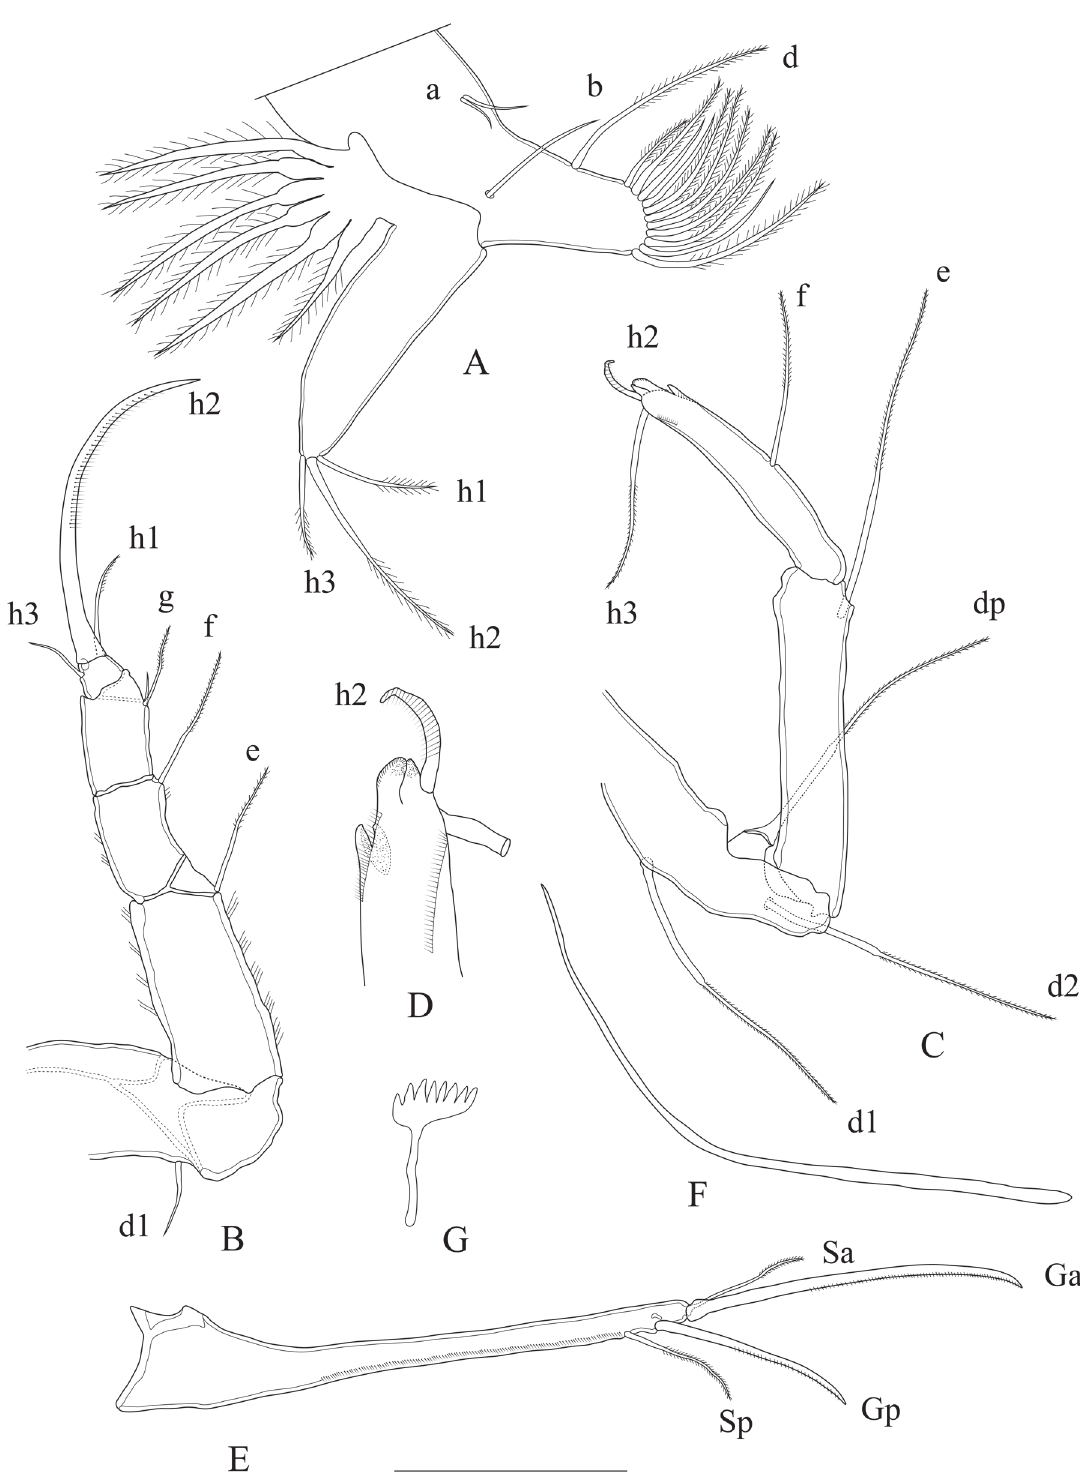
Fig. 6. Cyprinotus drubea sp. nov., ♀♀. A . T1 (MNHN-IU-2019-2542). B . T2 (MNHN-IU-2019-2541). C . T3 (MNHN-IU-2019-2541). D . Detail of apical pincer of T3 (MNHN-IU-2019-2541). E . CR (MNHN-IU-2019-2542). F . Attachment of CR (MNHN-IU-2019-2542). G . Rake-like organ (MNHN- IU-2019-2542). Scale bar: A = 111 µm; B = 93 µm; C = 106 µm; D = 42 µm; E–F = 127 µm; G = 104